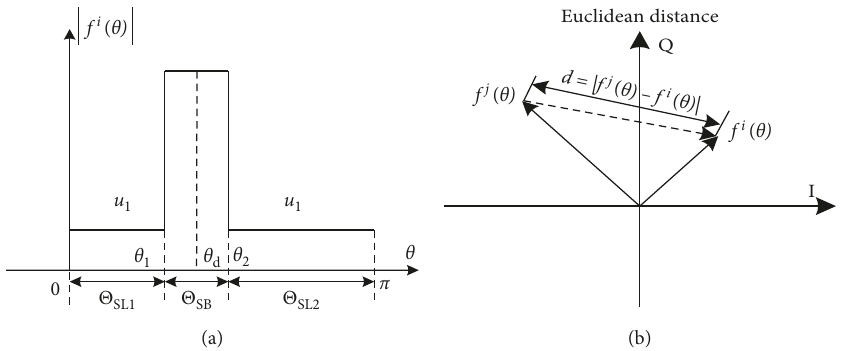
Figure 2: The constraint of (a) sidelobe and (b) Euclidean distance for DM synthesis algorithm.